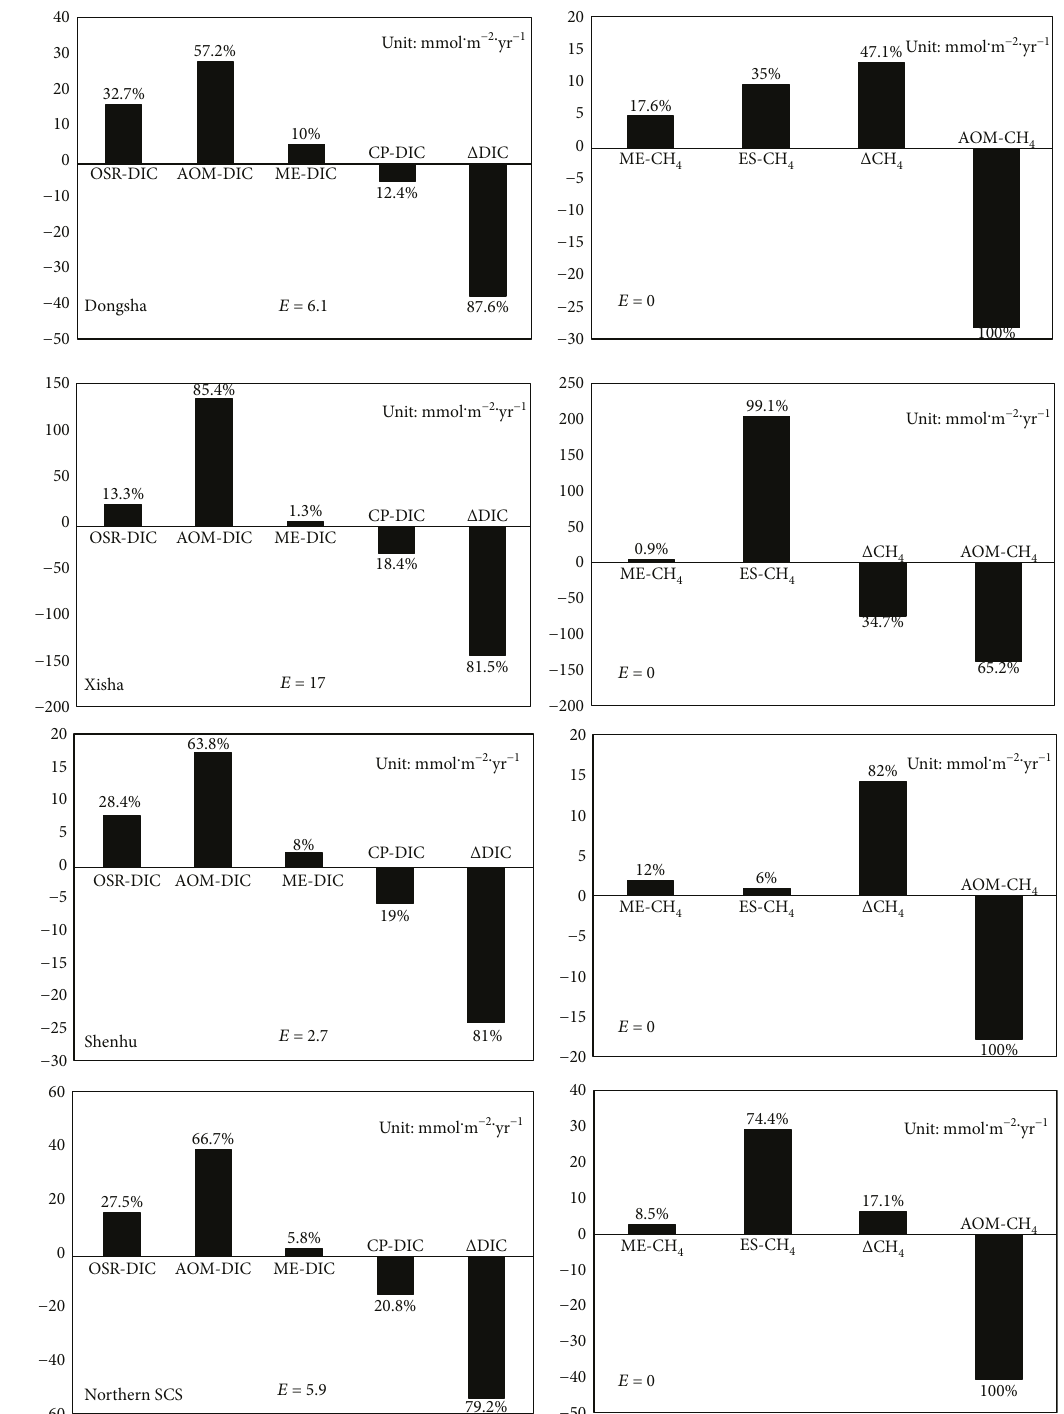
Figure 3: Sources and sinks of methane and DIC in the shallow sediments. Positive values denote sources of methane or DIC and negative values denote sinks of methane or DIC. OSR: organoclastic sulfate reduction; AOM: anaerobic oxidation of methane; ME: methanogenesis; CP: carbonate precipitation; ES: external methane from the bubble dissolution within modeled sediment columns. Δ represents di ff erence between fl uxes at the lower boundary and fl uxes at the upper boundary. Percentages above or below each column represent the contributions of each biogeochemical reaction to the source/sink. E denotes the di ff erences between sources and sinks of methane and DIC. Biogeochemical rates (OSR, AOM, ME, and CP) in the three regions and northern SCS are adopted from Table 1. The ES-CH obtained by assuming a complete mass conservation of